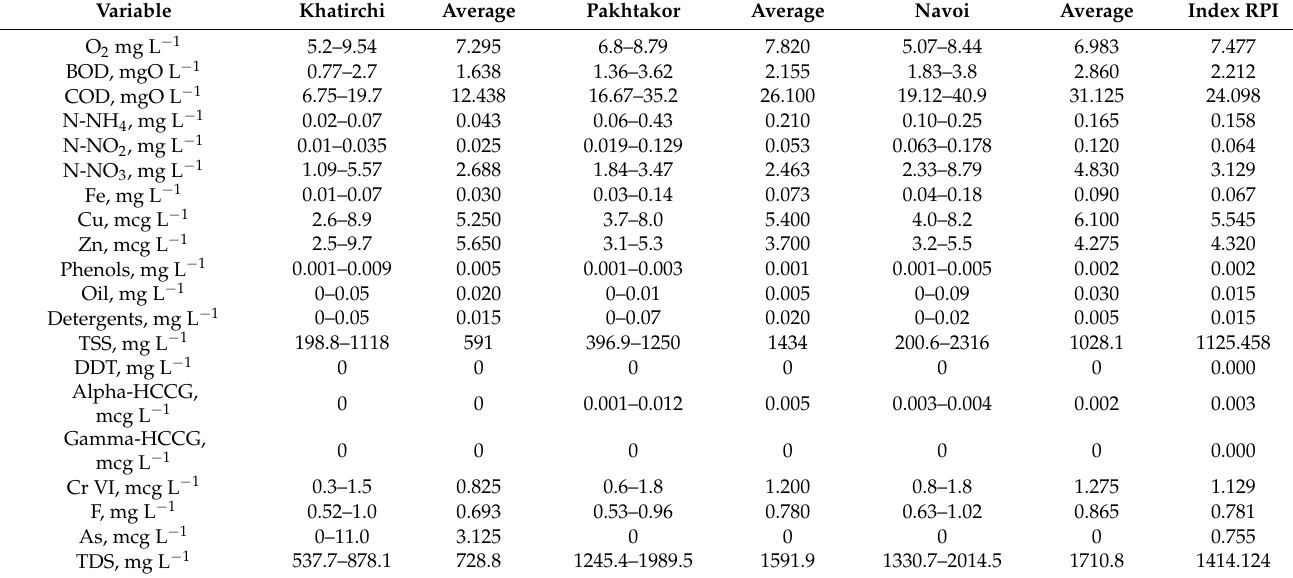
Table 2. Range and average value of hydrochemical variables and index RPI in 3 sites of the Zarafshan River, 2009–2015.